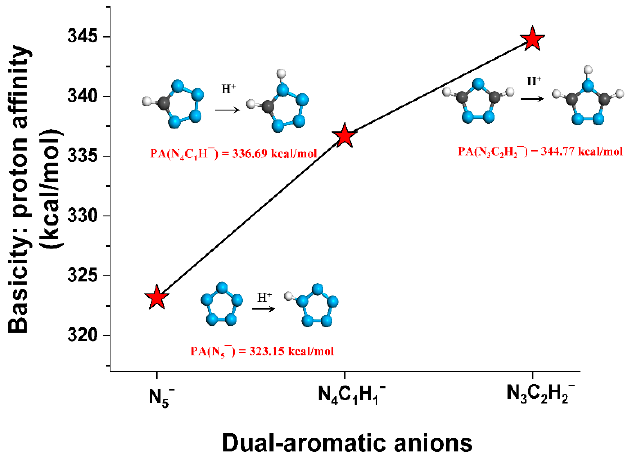
Figure 2. Basicity: proton affinity of pentazole anion N 5 ¯, tetrazole anion N 4 C 1 H 1 ¯, and 1,2,4-triazole anion N 3 C 2 H 2 ¯.